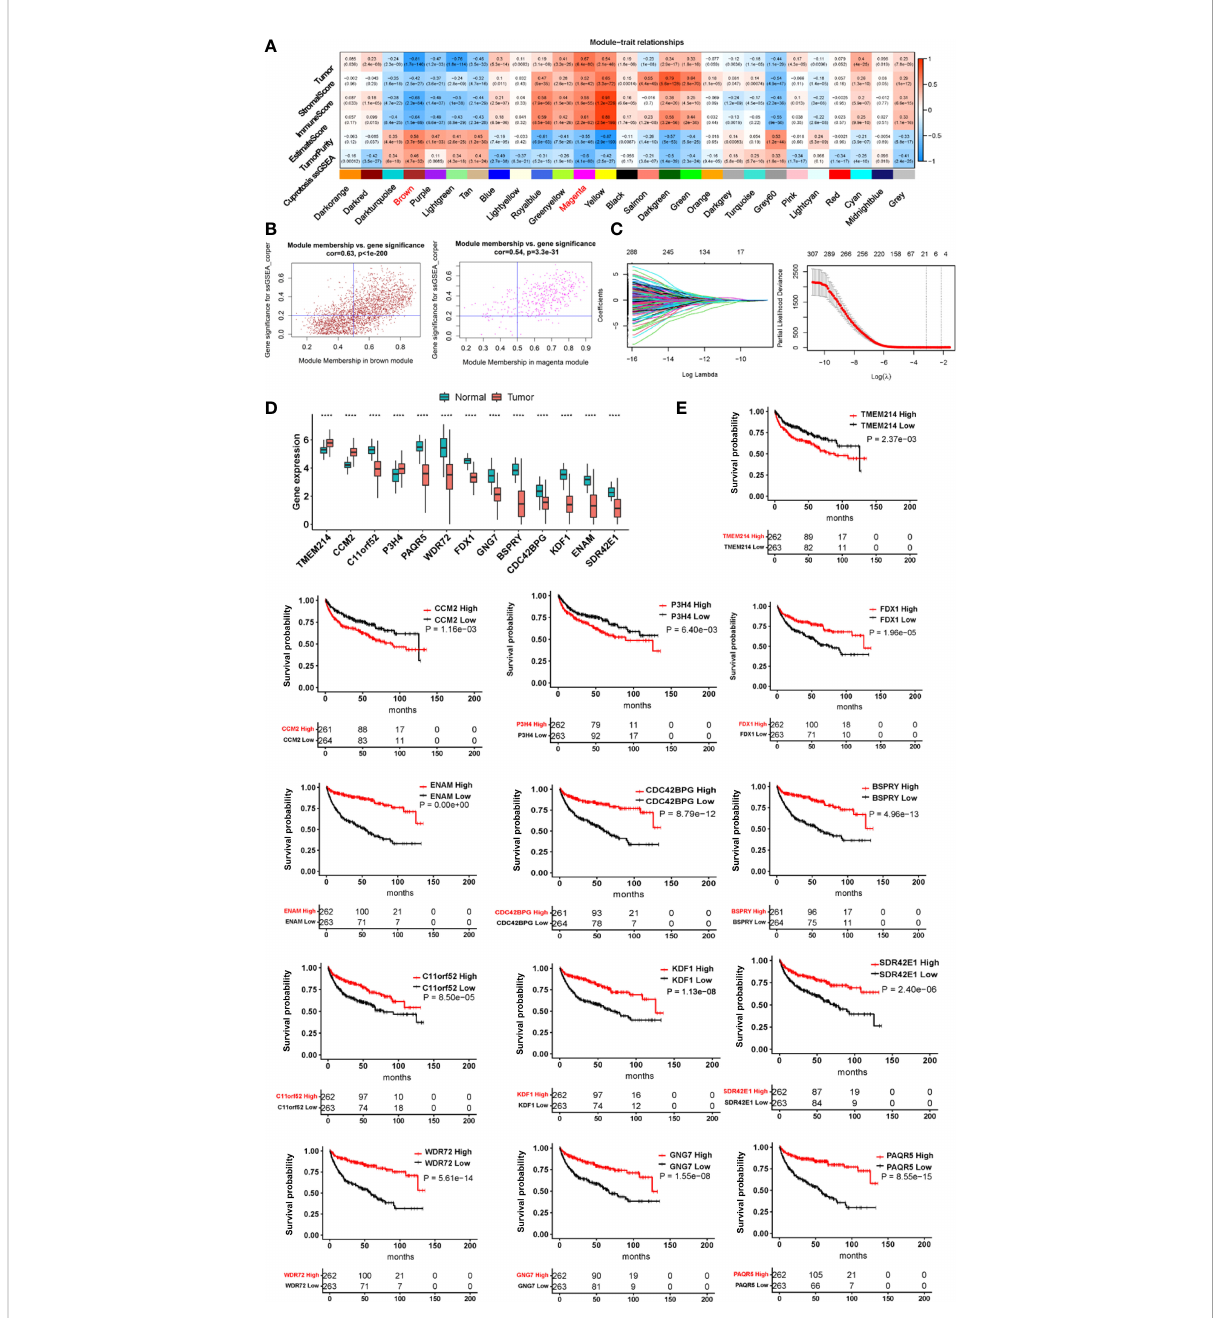
FIGURE 2 The construction of the cuproptosis-associated 13 gene signature (CuAGS-13) for ccRCC prognosis. (A) Left panel: Gene modules correlated with cuproptosis factors as determined using Weighted gene co-expression network analysis (WGCNA) and Pearson ’ s co-ef fi ciency analysis. (B) Scatter plot of module eigengenes in the MEBROWN (left) and MEMANGE (right) modules from (A) . The genes in the upper right are selected for further analyses. (C) Construction of the cuproptosis-associated 13 gene signature (CuAGS-13) for progression-free survival (PFS) prediction in ccRCC. Top panel: LASSO coef fi cient pro fi les of the CuAGS associated with PFS. Bottom panel: Plots of the cross-validation error rates. Each red dot represents a lambda value with its error bar (the con fi dence interval for the cross-validated error rate). The analysis identi fi ed 13 cuproptosis-associated genes most relevant to PFS. (D) Differences in the CuAGS-13 expression between ccRCC tumors and their non- tumorous adjacent renal tissues in the TCGA cohort. (E) Kaplan – Meier survival analysis showing the impact of each gene contained in CuAGS- 13 on PFS in the TCGA ccRCC cohort. Patients are divided into high and low groups based on the expression of each gene in tumors using a median value as the cutoff. ****p <